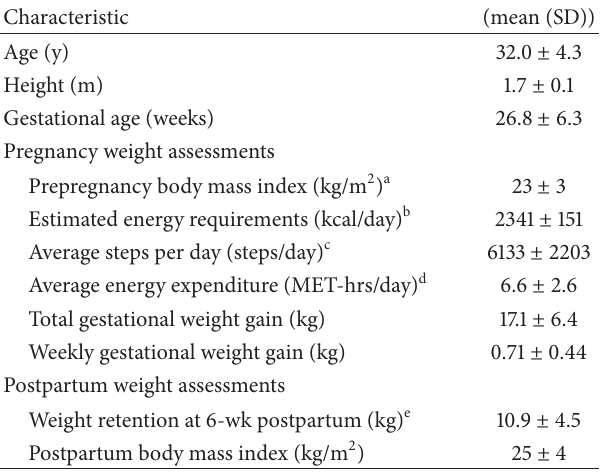
Table 1: Population characteristics ( 𝑛 = 54 ).